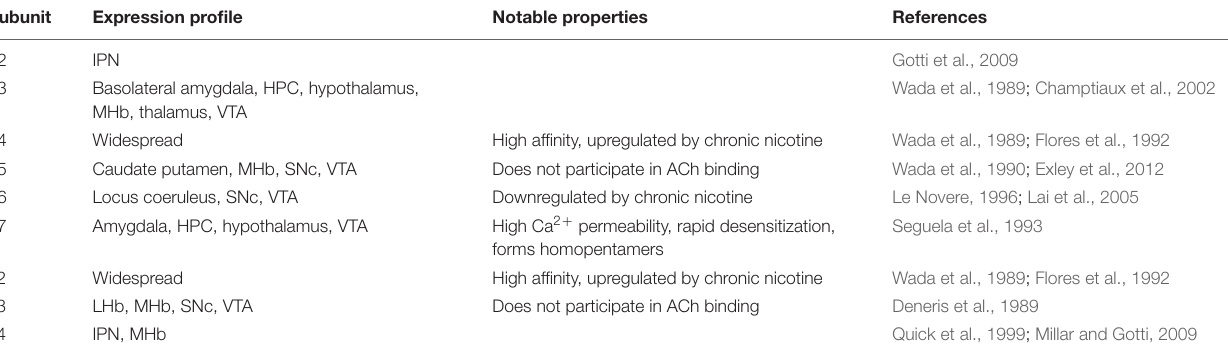
TABLE 1 | Summary of neuronal nAChR subunit expression in reward circuitry of adult rodents.